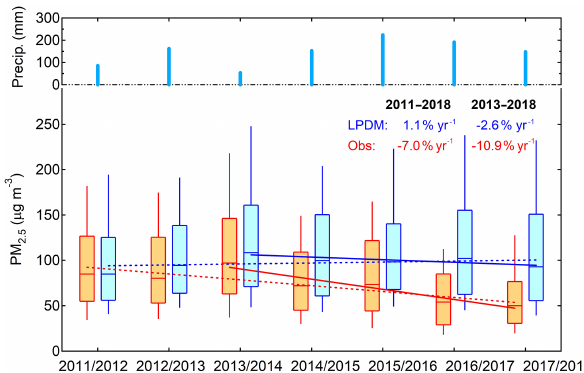
Figure 8. Statistics of PM 2 . 5 concentrations from the SORPES ob- servation and the scaled LPDM simulations to the first-year obser- vation (lower panel) and a sum of 3-month TRMM precipitation averaged in a 2 ◦ × 2 ◦ grid (31–33 ◦ N, 118–120 ◦ E) around SOR- PES (upper panel) for November–December–January during 2011– 2018. value of 84.8 µg m − 3 in 2011–2012 to 108.4 µg m − 3 in